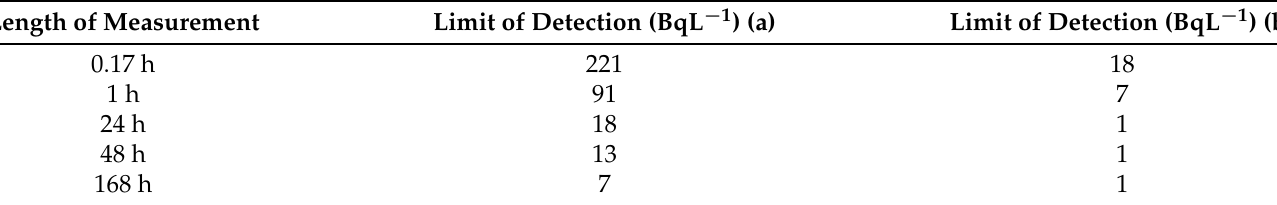
Table 4. The limit of measurement for 90 Sr in a 10 mm × 10 mm × 3 µ m gallium-arsenide (GaAs) detector (a) and a 35 mm × 35 mm × 30 µ m GaAs detector (b) for increasing lengths of detection. Length of